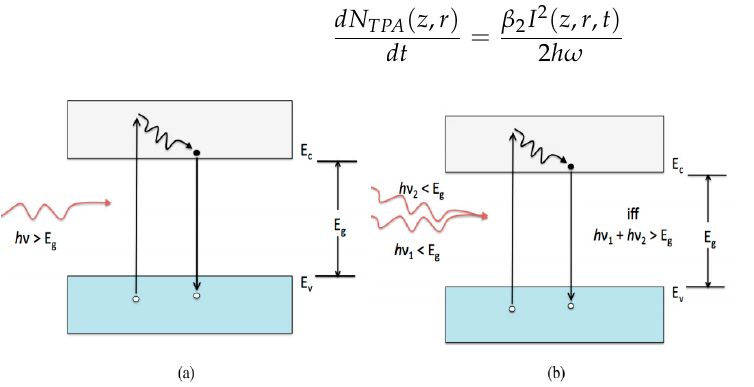
Figure 1. Mechanisms of SPA and TPA. (( a ): single photon absorption, ( b ): two photon absorption).